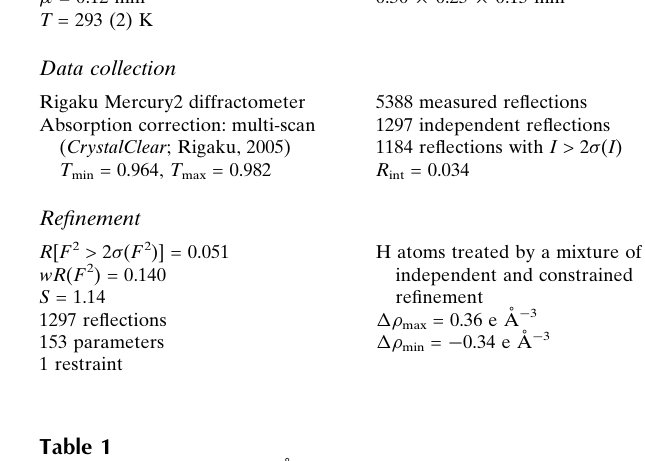
Hydrogen-bond geometry (A˚ , (cid:2)